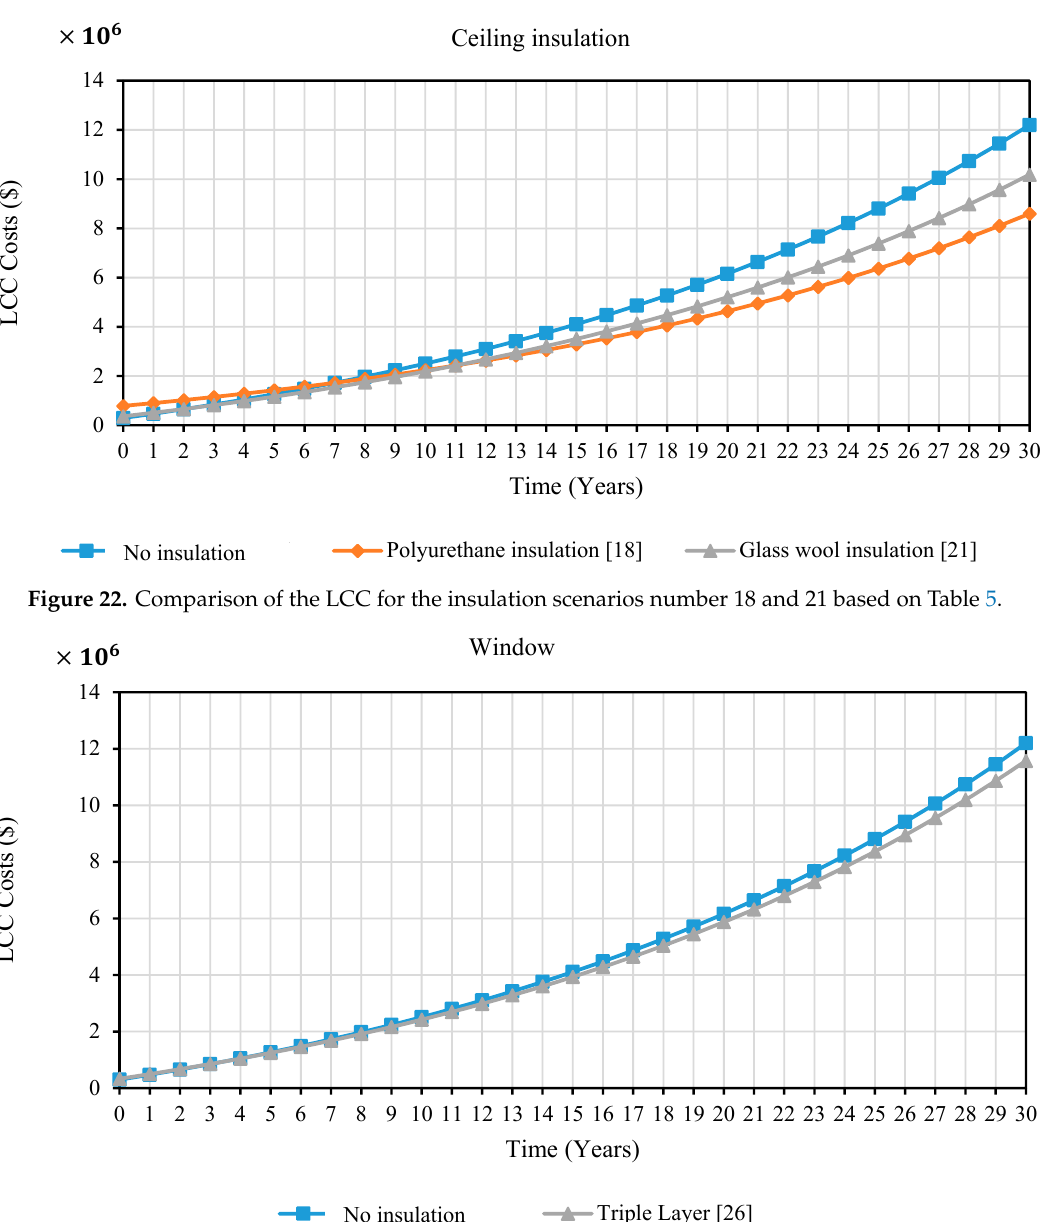
Figure 21. Comparison of the life cycle cost (LCC) for the insulation scenarios number 6 and 9 based on Table 5.